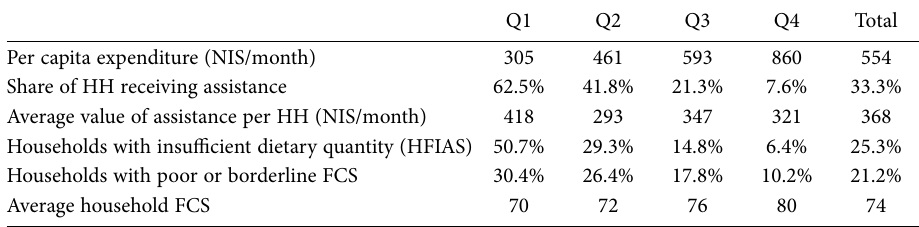
Authors’ elaboration on SEFSec 2014